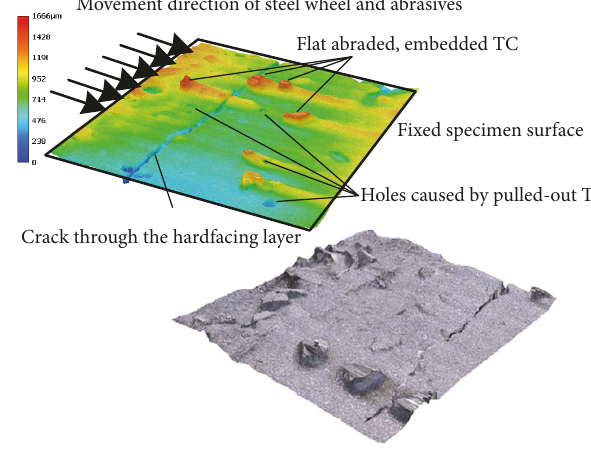
Figure 8: 3D surface scan of a worn hardfacing layer with included coarse tungsten carbide ( >